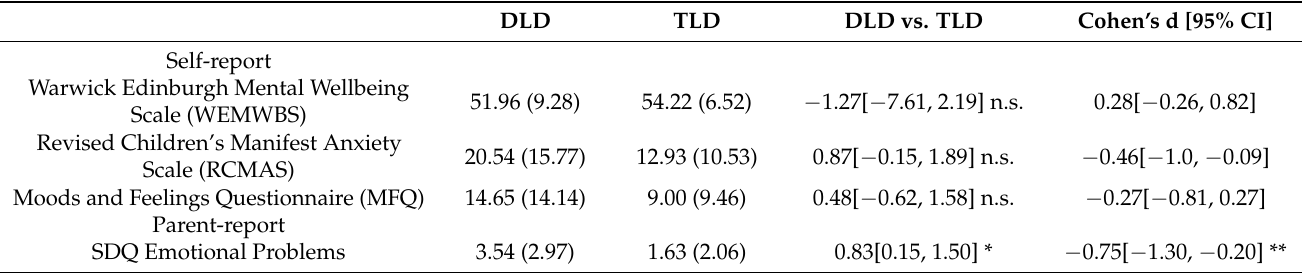
Statistics are b coefficients [95% confidence interval], controlling for IDACI Rank Z-score. Regressions for RCMAS and MFQ are performed on transformed data. *. p < 0.05, **. p <